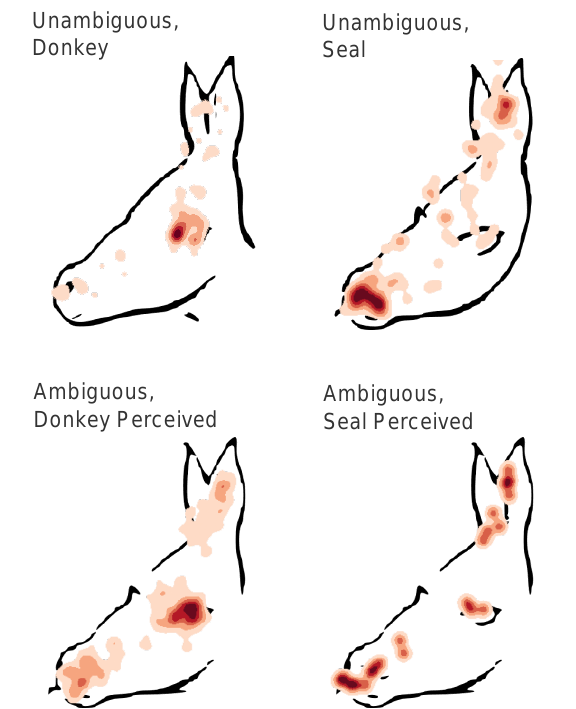
Figure 2. Examples of viewing behavior prior to object awareness on the unambiguous (upper row) and ambiguous (lower row) stimuli with corresponding percepts. There are differences between the groups with different percepts (left and right in lower row), and the differences in the viewing behavior on the ambiguous and unambiguous stimuli are aligned with identical percepts (vertical